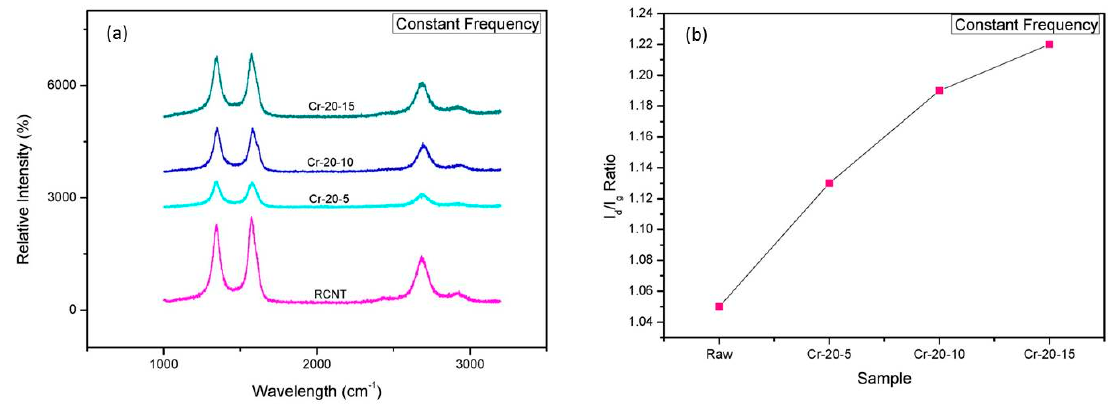
Figure 5. ( a ) Raman spectra; and ( b ) I d / I g ratios of RCNT, Cr-20-5, Cr-20-10, and Cr-20-15. The I d / I g graph shows that defects in CNTs increase as the cryomilling time increases.